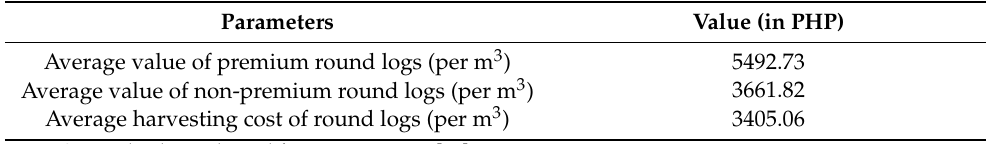
Table 2. Economic Parameters for Timber Harvesting